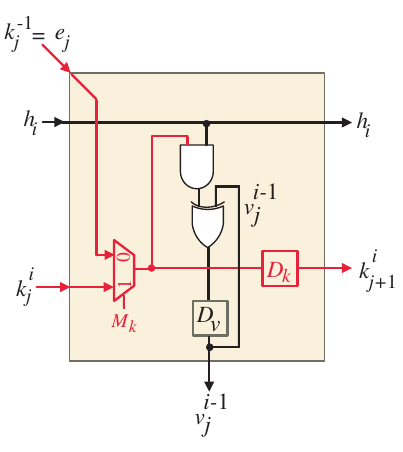
Figure 3. Bit-parallel systolic multiplier structure.